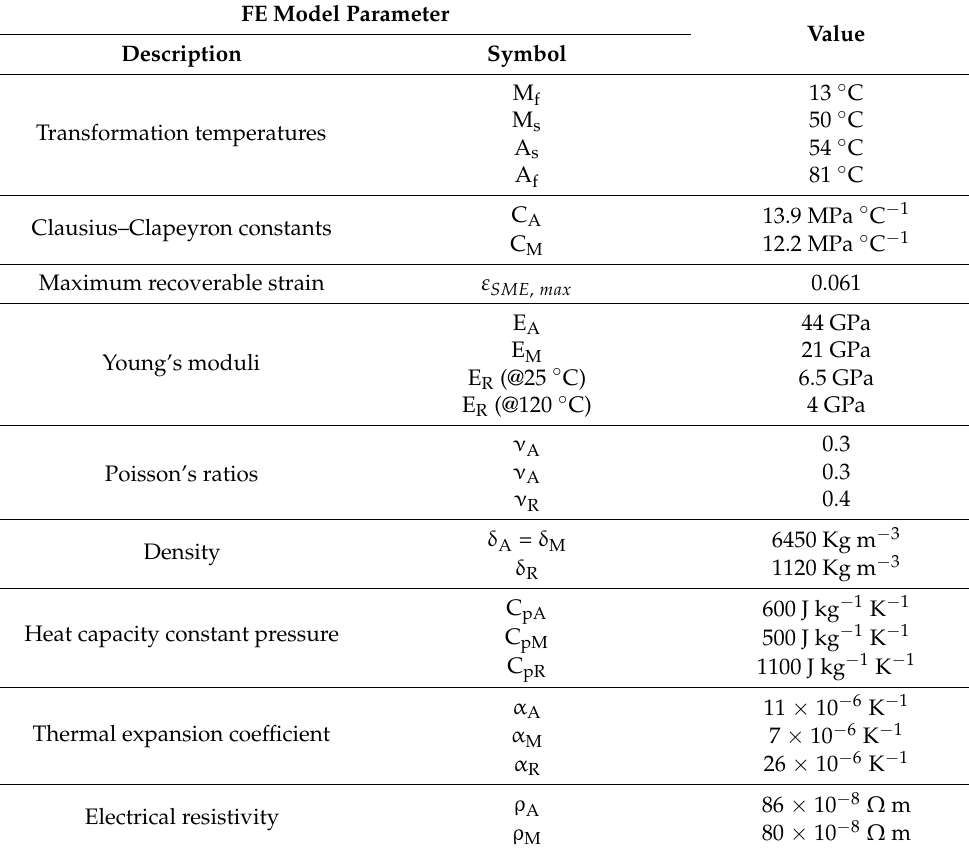
Table 3. Main physical parameters of SMA and polymer used in the FE